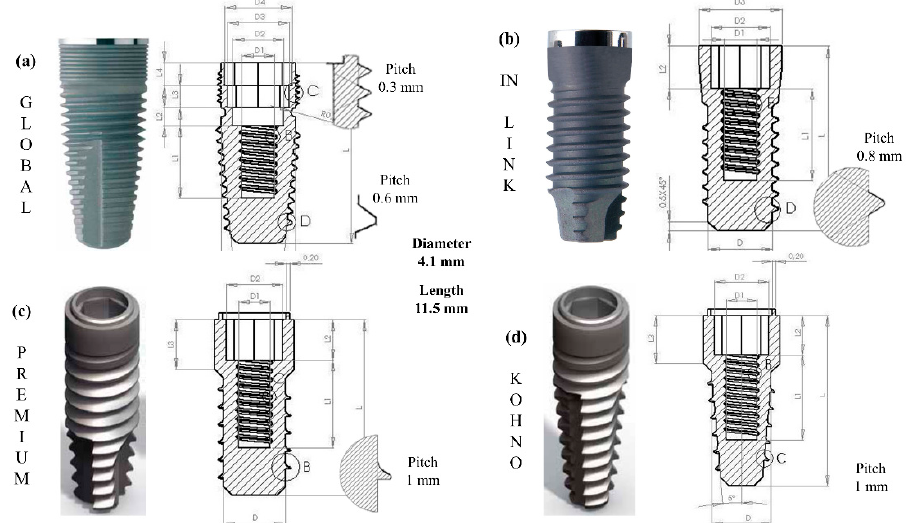
Figure 3. Adopted prosthetic devices: ( a ) Global; ( b ) In-Link; ( c ) Premium; ( d ) Kohno. Table 2. Finite element model dimensions.